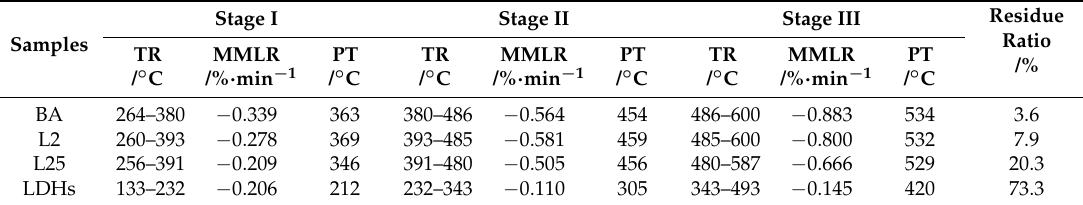
Table 3. Characteristic parameters of TG analysis of BA, L2, L25, and